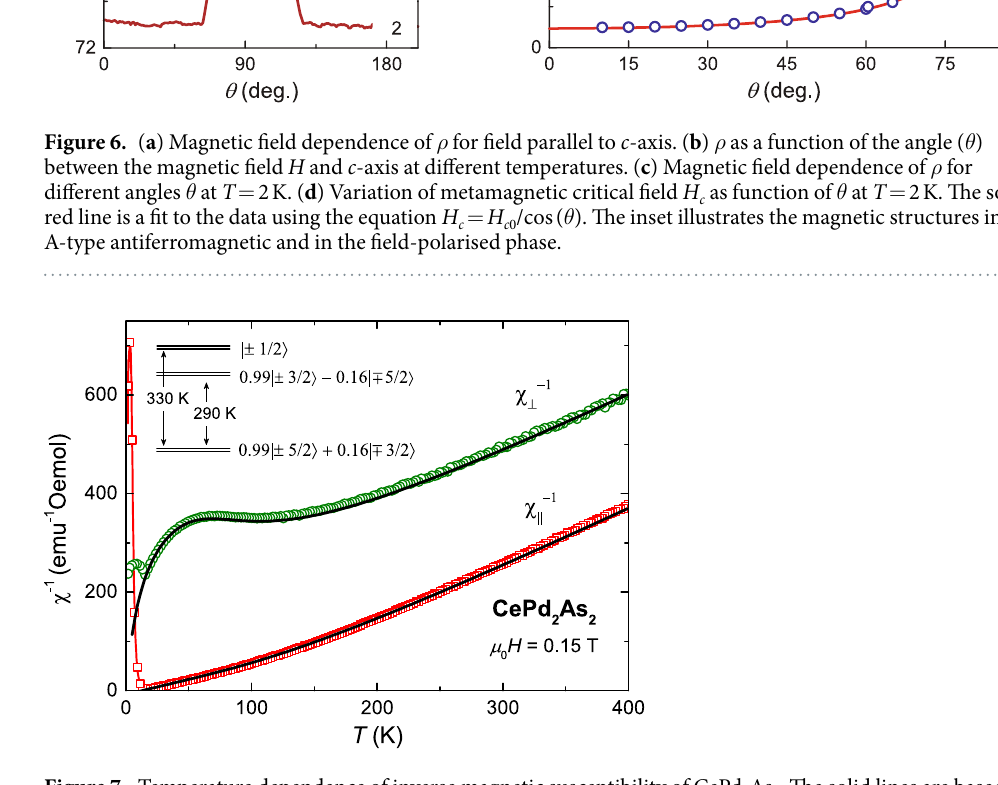
Figure 7. Temperature dependence of inverse magnetic susceptibility of CePd 2 As 2 . The solid lines are based on CEF calculation. A schematic representation of the CEF levels is shown in the